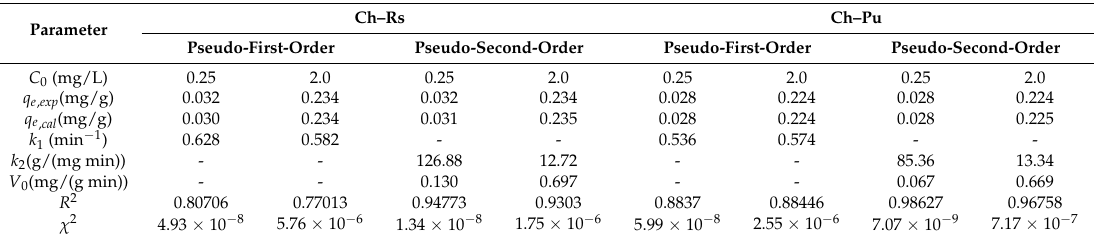
Table 2. Parameters of the pseudo-first-order and pseudo-second-order kinetic models for As(V) adsorption by Ch–Rs and Ch–Pu blends.